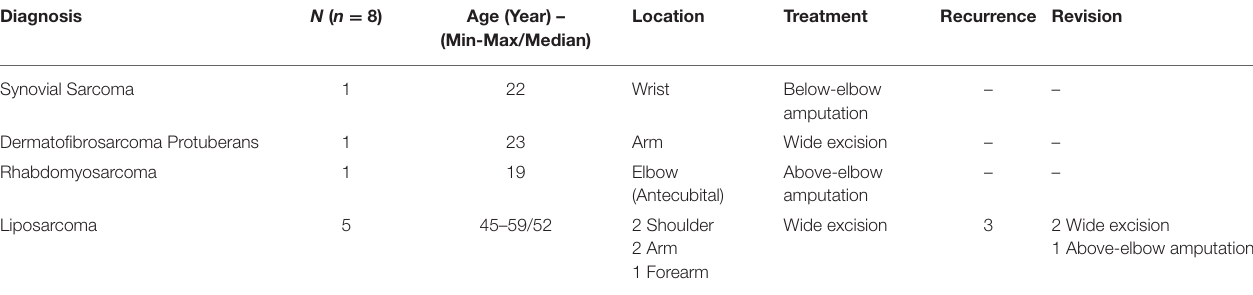
TABLE 3 | Malignant soft tissue tumors of the upper extremity. Diagnosis N ( n =